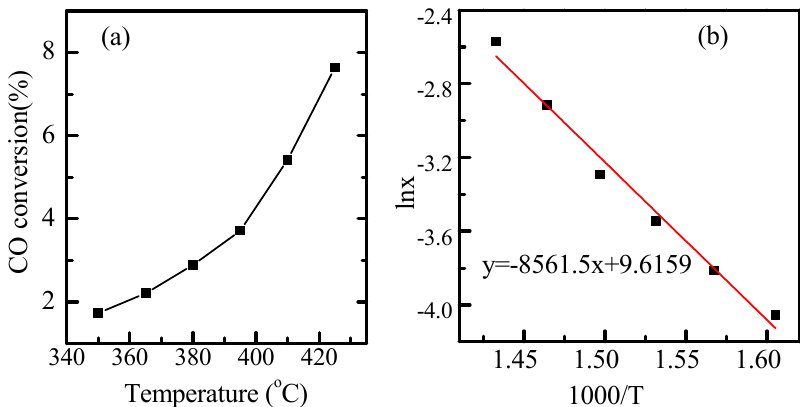
Figure 9. WGS activity performance ( a ) and Arrhenius plot ( b ) for the WGS reaction over Cu/Fe 3 O 4 nanorods catalyst from 350–425 °C. Here, x is the CO conversion, reaction conditions: 1 vol.% CO, 3